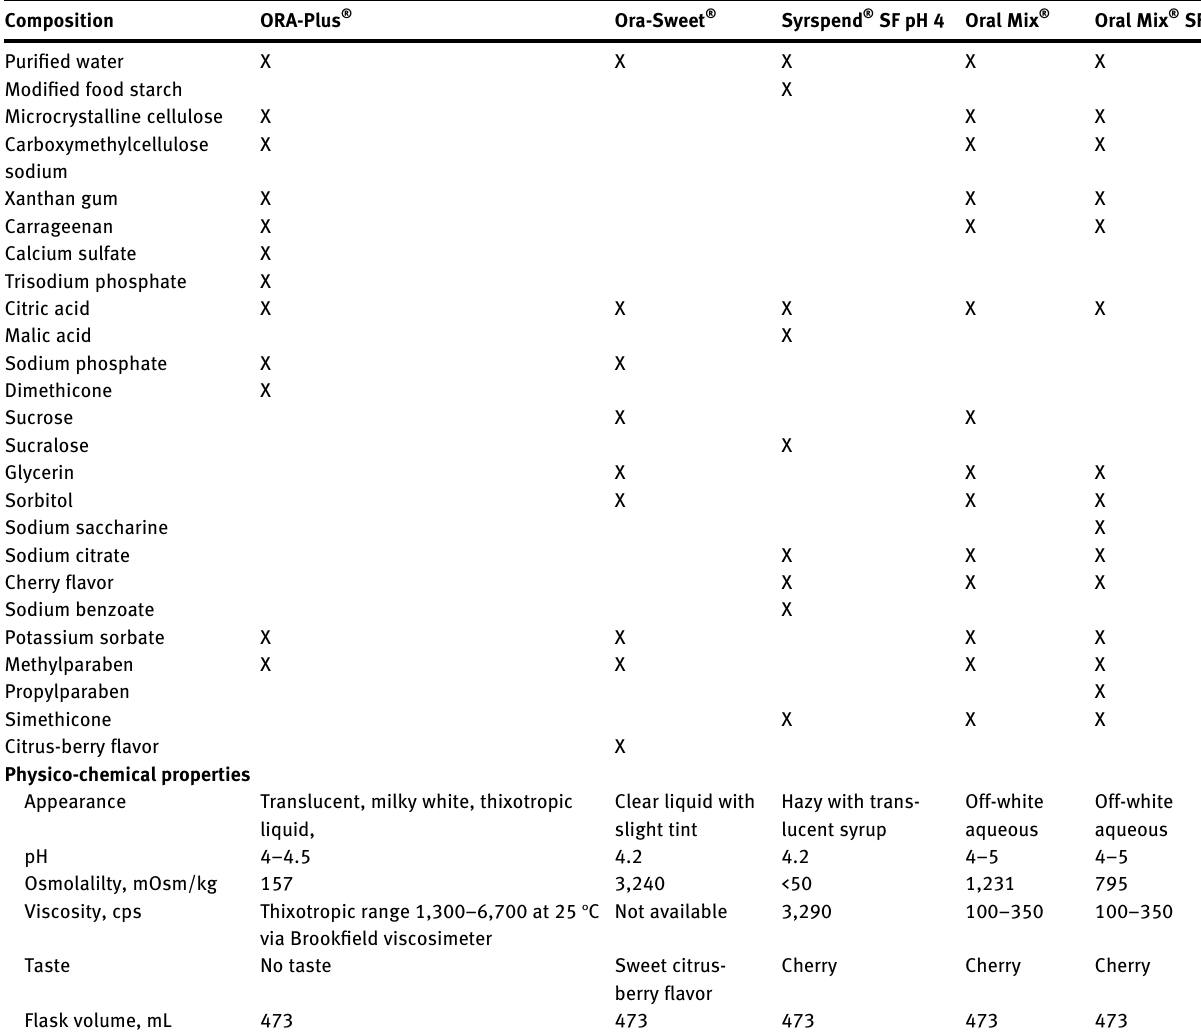
Table  : Comparison of ready to use liquid bases for oral suspension compounding.